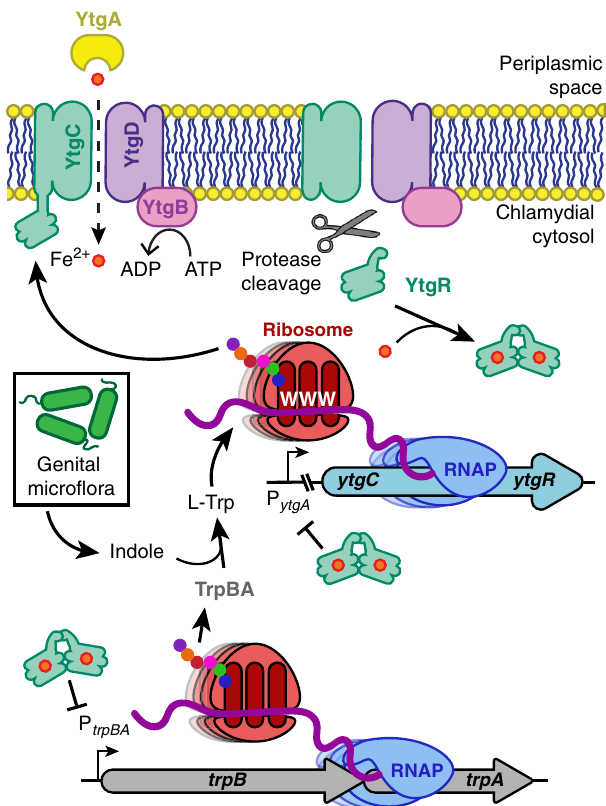
Fig. 6 Model of tryptophan-dependent regulation of YtgR expression and YtgR-mediated trpBA repression. Under tryptophan-replete conditions, ribosomes are able to read through the WWW codon motif on the nascent ytgCR message transcribed by the RNA polymerase (RNAP) to translate the full-length YtgCR. Cleavage from YtgC allows YtgR to dimerize and coordinate iron to gain repressor functionality. YtgR then maintains repression of trpBA from the intergenic region. In contrast, tryptophan depletion inhibits ribosome readthrough at the WWW motif, reducing protein expression of YtgR and terminating downstream transcription of the YtgR domain in a Rho-independent manner. Thus, YtgR levels are reduced and trpBA is de-repressed by YtgR. This allows for tryptophan salvage from indole provided by the genital micro fl ora via the activity of the TrpBA synthase, which can restore YtgR levels and transcriptional repression of trpBA . Some elements in this fi gure have been used in previously published fi gures 24,38 and were adapted for use here, with some changes, under the Creative Commons license CC BY 4.0: https://creativecommons.org/ Our data indicate that YtgR is a nexus of the chlamydial response to iron and tryptophan limitation. We suspect that the WWW motif performs an important regulatory function during Ctr infection of the female LGT by connecting the availability of LGT is both indole-rich and iron-poor, which provides necessary